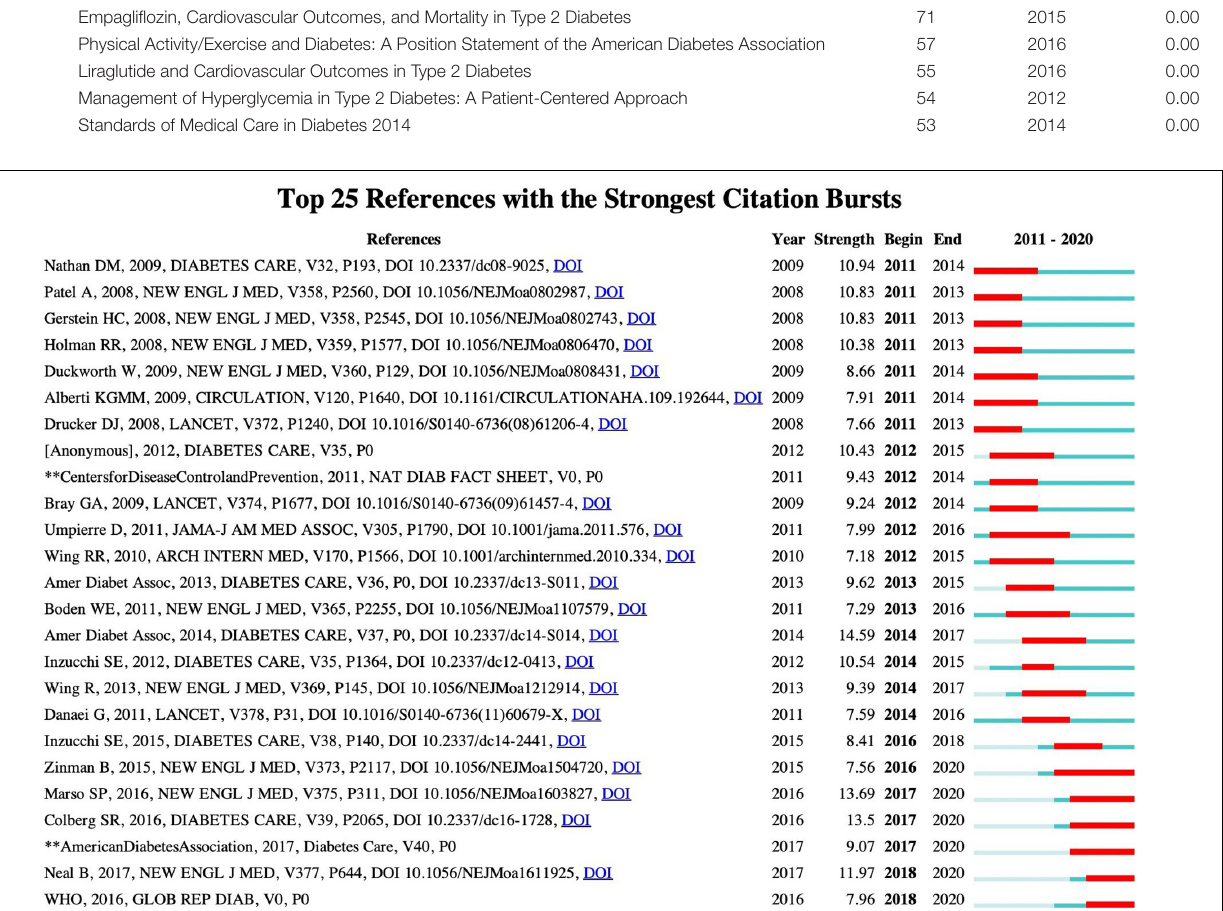
FIGURE 7 | The top 25 references with the strongest citation bursts in physical activity therapy for diabetes research.